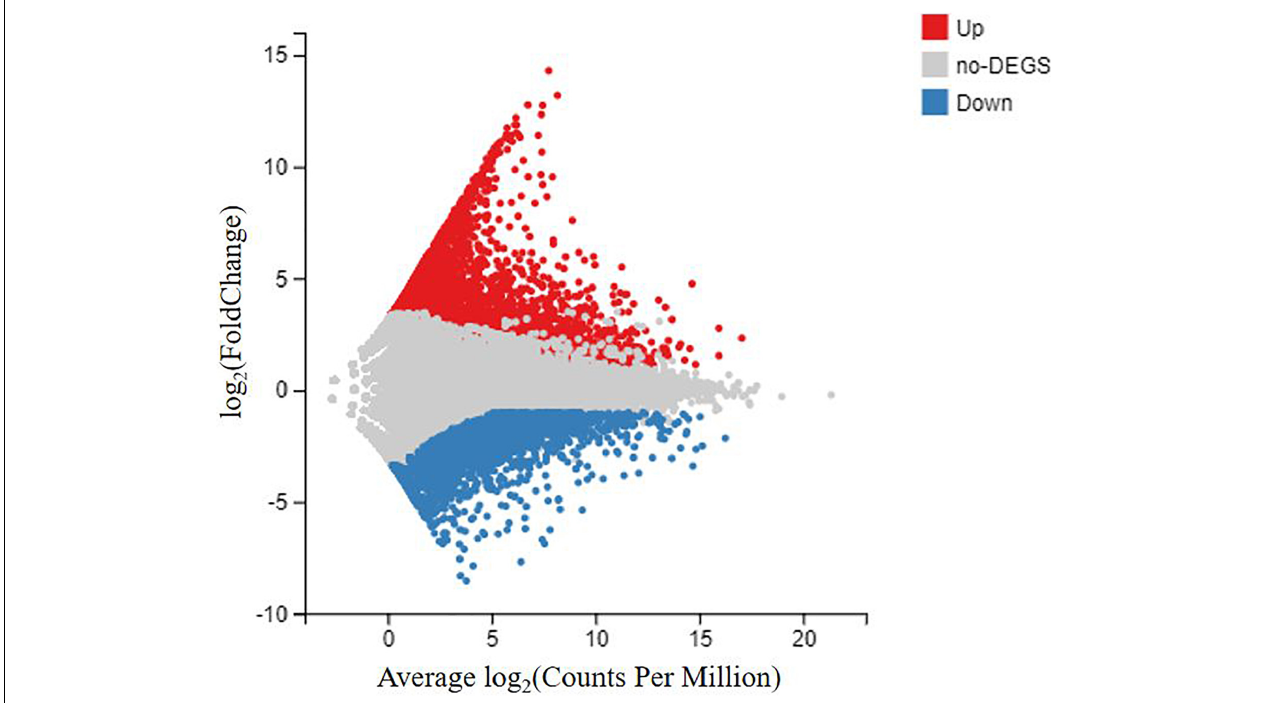
FIGURE 7 | MA plot between differentially expressed genes (DEGs) of the DIV1-infected group and the negative control group of Marsupenaeus japonicus hemocytes. The X -axis indicates the average expression level, and the Y -axis indicates the fold change. Red dots represent the significantly upregulated DEGs, while blue dots represent the significantly downregulated DEGs [ q -value < 0.05 and | log 2 (fold change)| > 1]. Gray dots represent the DEGs which were not significantly